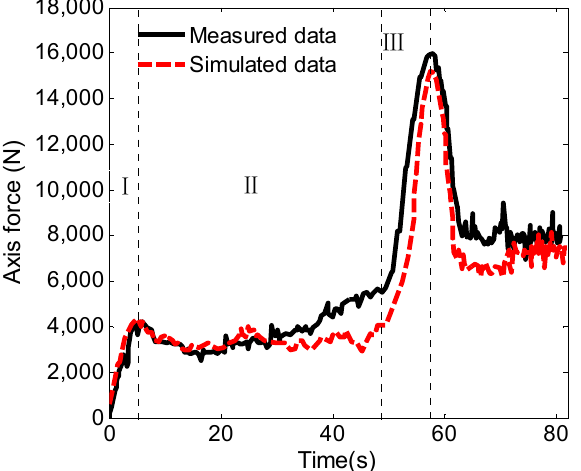
Figure 7. Axis force curve in the Z direction.